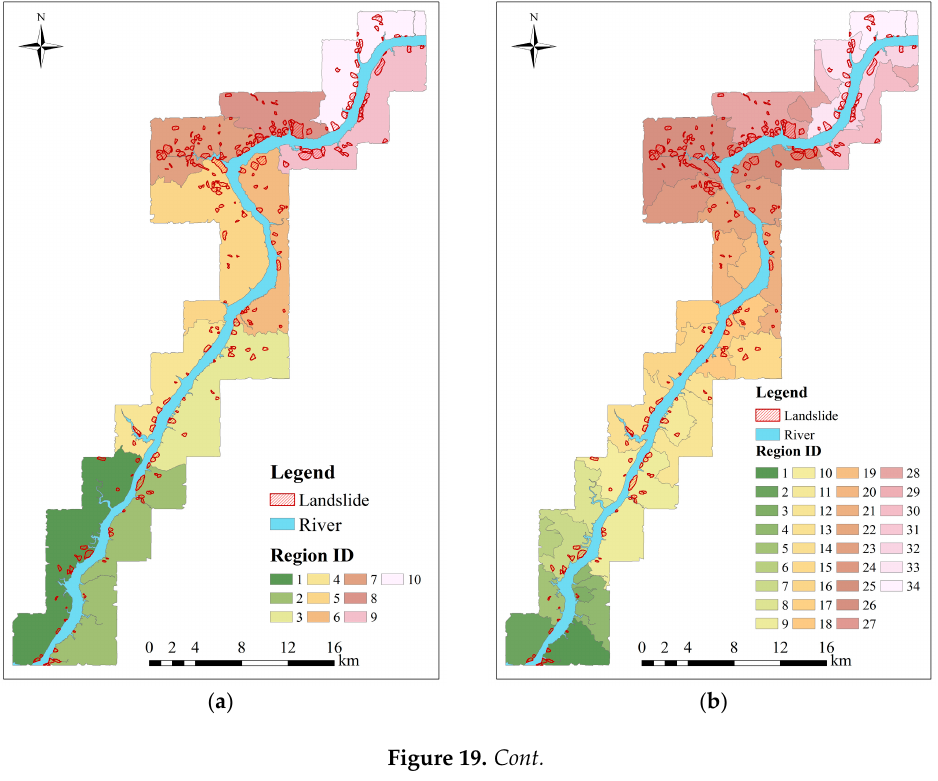
Figure 19 . Cont . Figure 19.